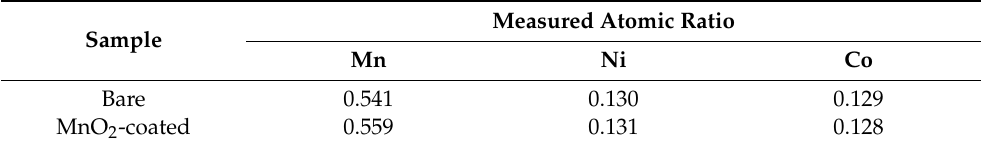
Figure 3. The elemental distributions of Mn, Ni, and Co in the bare and MnO 2 -coated LTMO parti- cles.